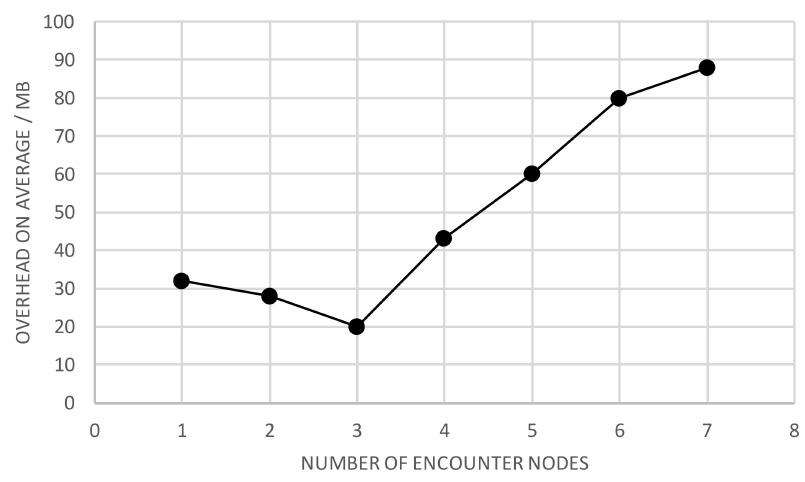
Figure 7. The relationship between overhead and encounter